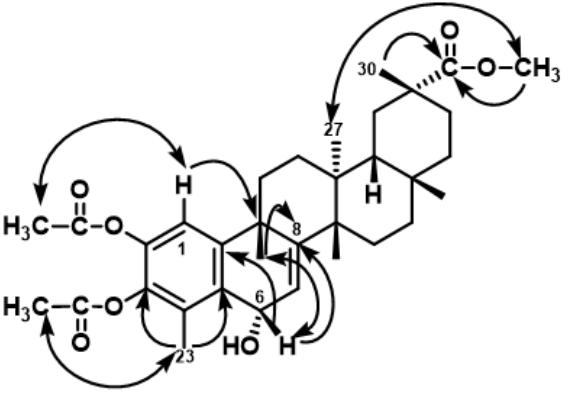
Figure 3. Selected HMBC (single arrow) and ROE (doubled arrow) correlations for compound 6 .